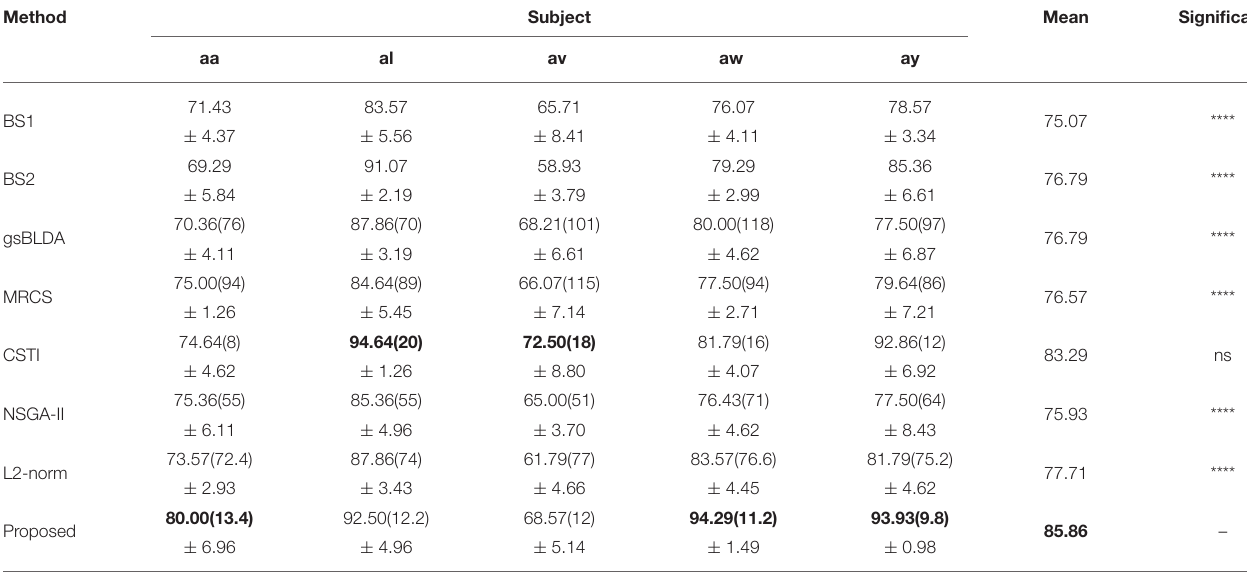
TABLE 3 | The mean classification accuracy and standard deviation (%) of 5 cross-validation with the number of corresponding channels (listed in the bracket) of COL and baselines on 5 subjects of DS1.